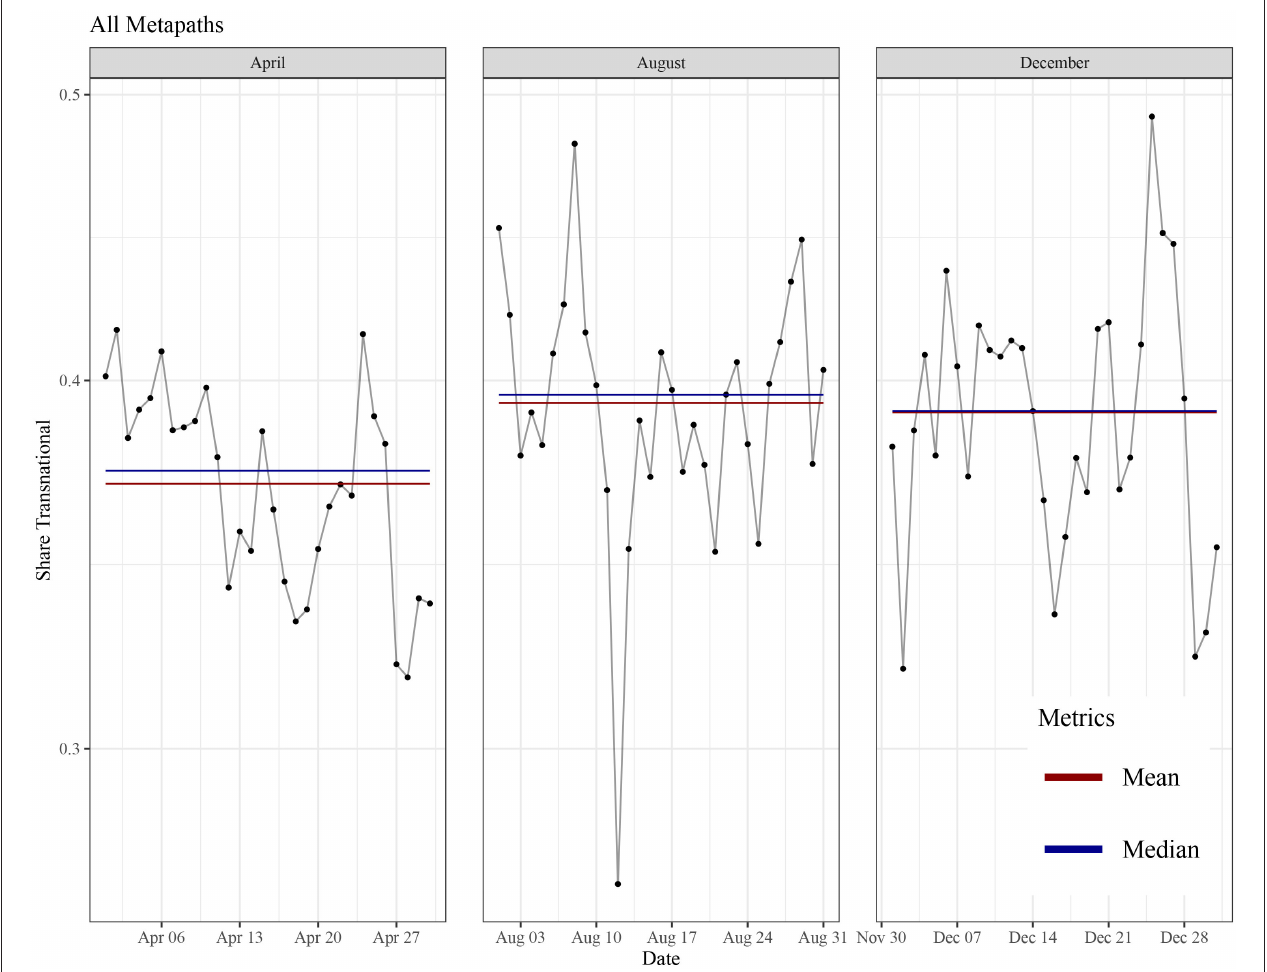
FIGURE 2 | Share of transnational linkages aggregated over all meta paths. The subfigures show the development of the share on a daily base (black line), monthly mean (red line) and monthly median (blue line). for the 3 months in the sample. The shares are presented on a logarithmic scale (y- axis) to better account for different